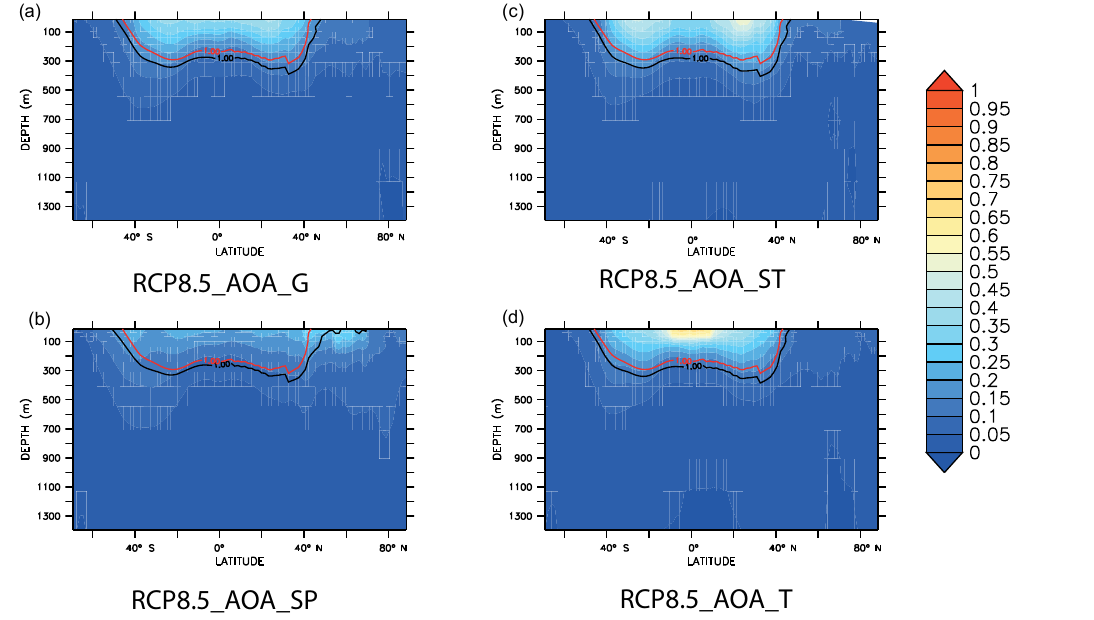
Figure 11. The zonal mean differences in aragonite saturation state in 2090 (mean; 2081–2100), associated with global and regional AOA under RCP8.5, relative to RCP8.5 with no AOA. Contoured on each map are the values of aragonite saturation state of 1; please see the text for more explanation. The red contours represent RCP8.5 without AOA and the black contours represent RCP8.5 with AOA for each